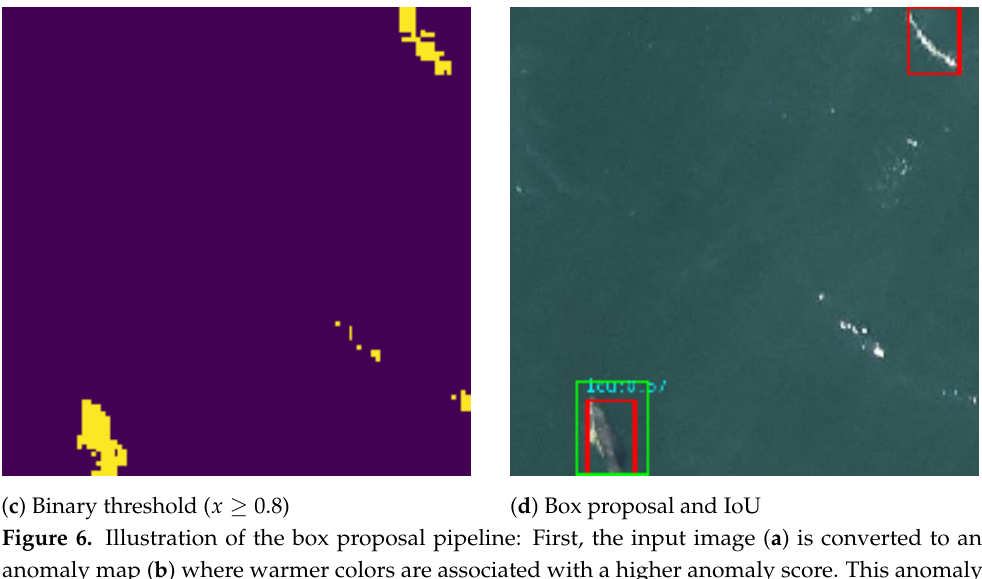
Figure 6. Illustration of the box proposal pipeline: First, the input image ( a ) is converted to an anomaly map ( b ) where warmer colors are associated with a higher anomaly score. This anomaly map is then converted to a binary mask ( c ). Finally, the propositions (red boxes) are compared with the ground truth boxes (green) using the IoU ( d